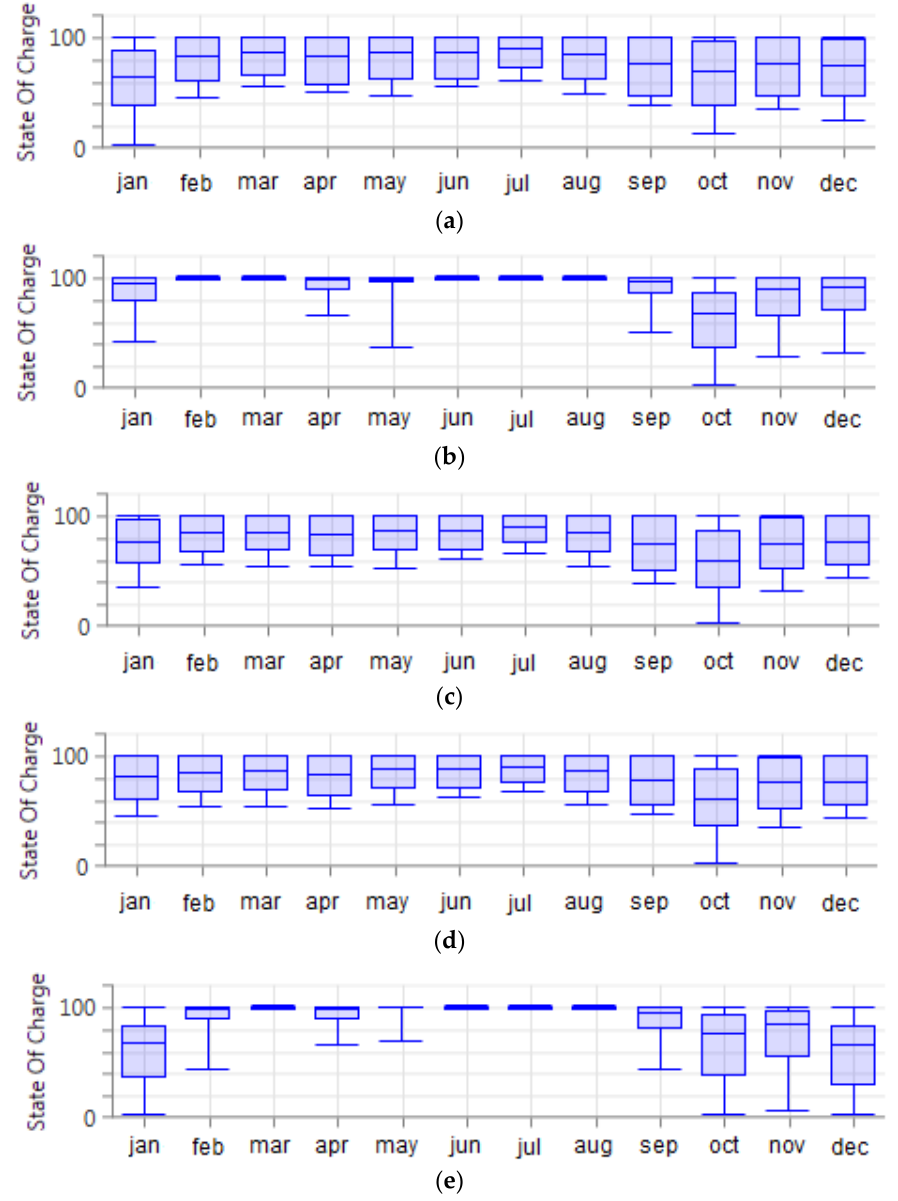
Figure 14. Monthly data of the mega-batteries storage system. ( a ) Tenerife; ( b ) Gran Canaria; ( c ) Lanzarote; ( d ) Fuerteventura; ( e ) La Palma.